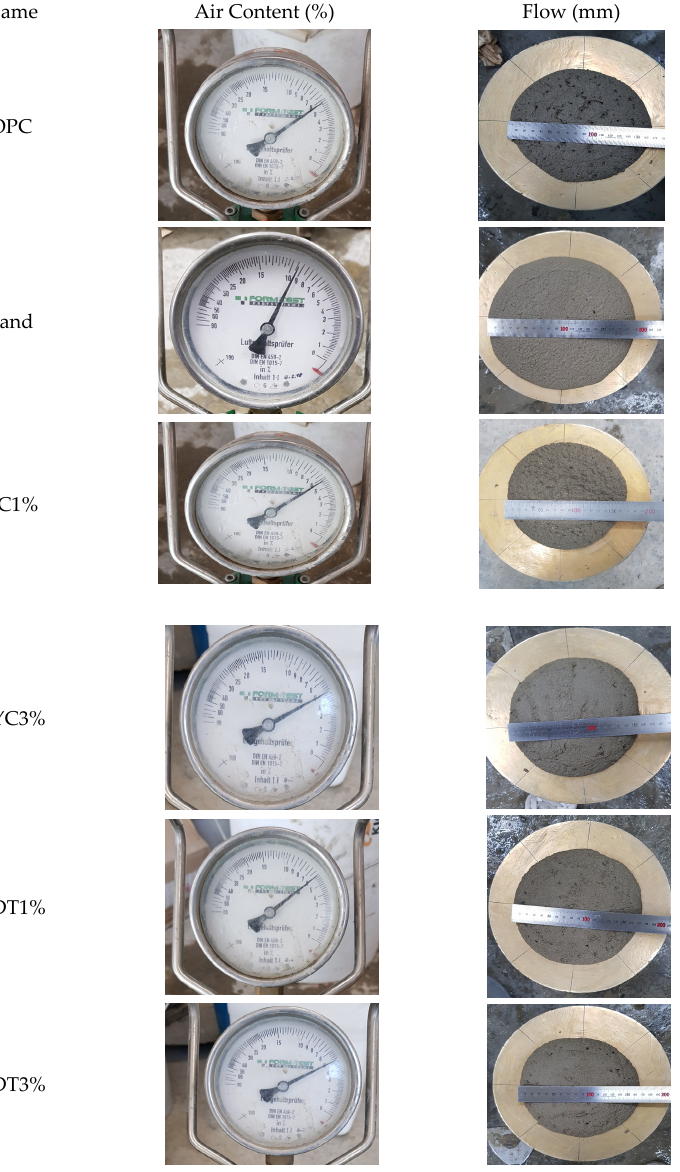
Figure 7. Measurement of the physical properties.